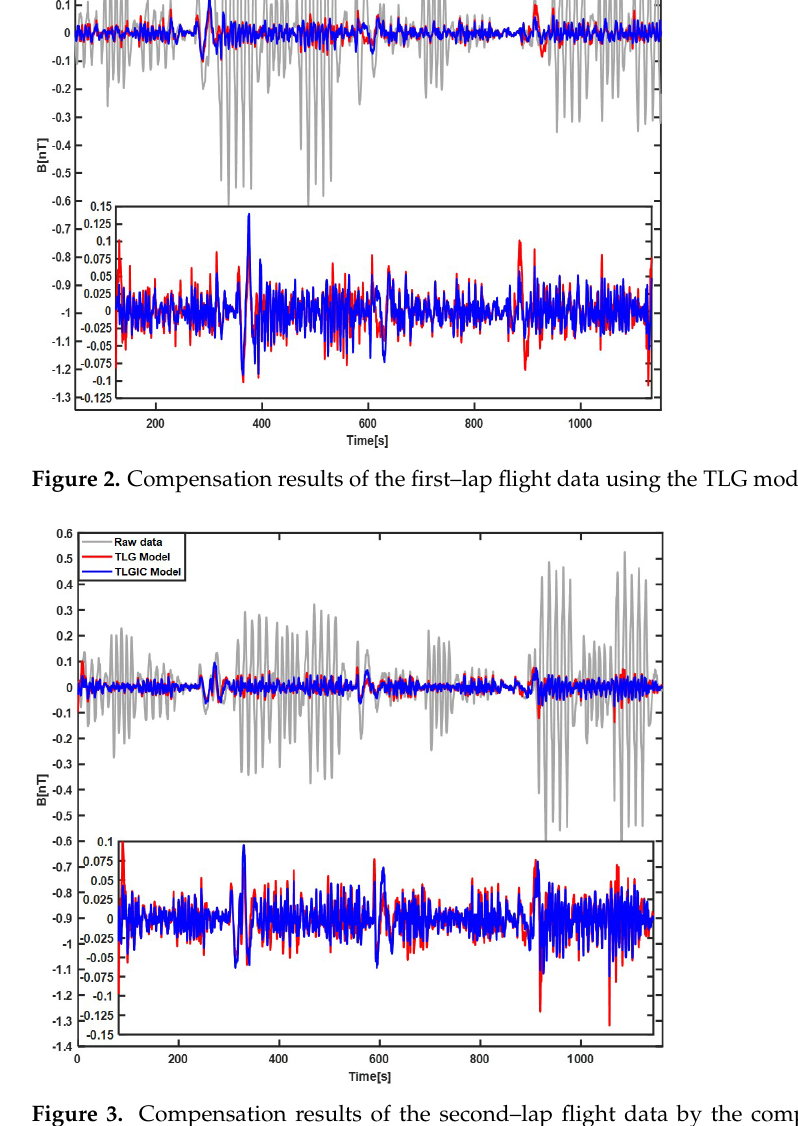
Figure 3. Compensation results of the second–lap flight data by the compensation coefficients calculated in the first–lap